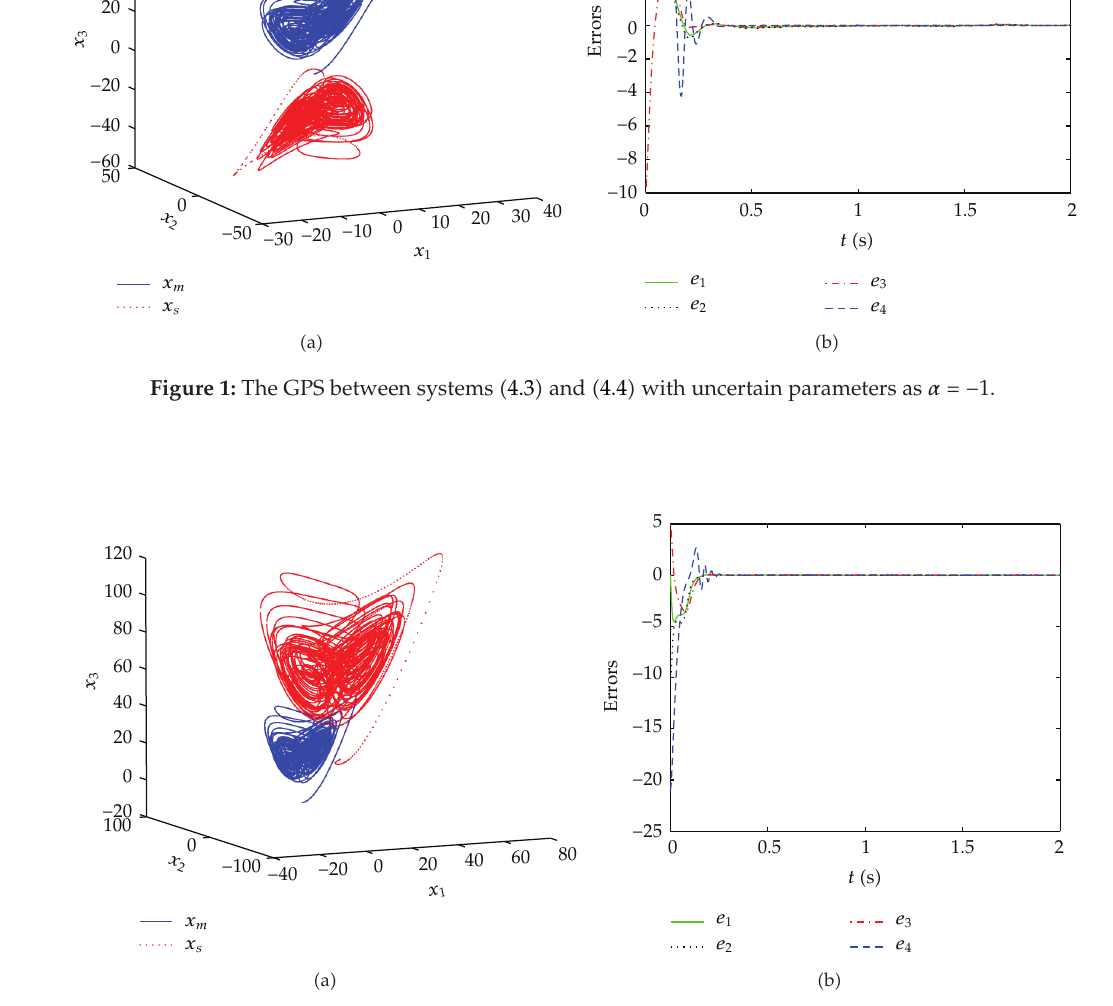
Figure 2: The GPS between systems (cid:2) 4.3 (cid:3) and (cid:2) 4.4 (cid:3) with certain parameters as α (cid:7)